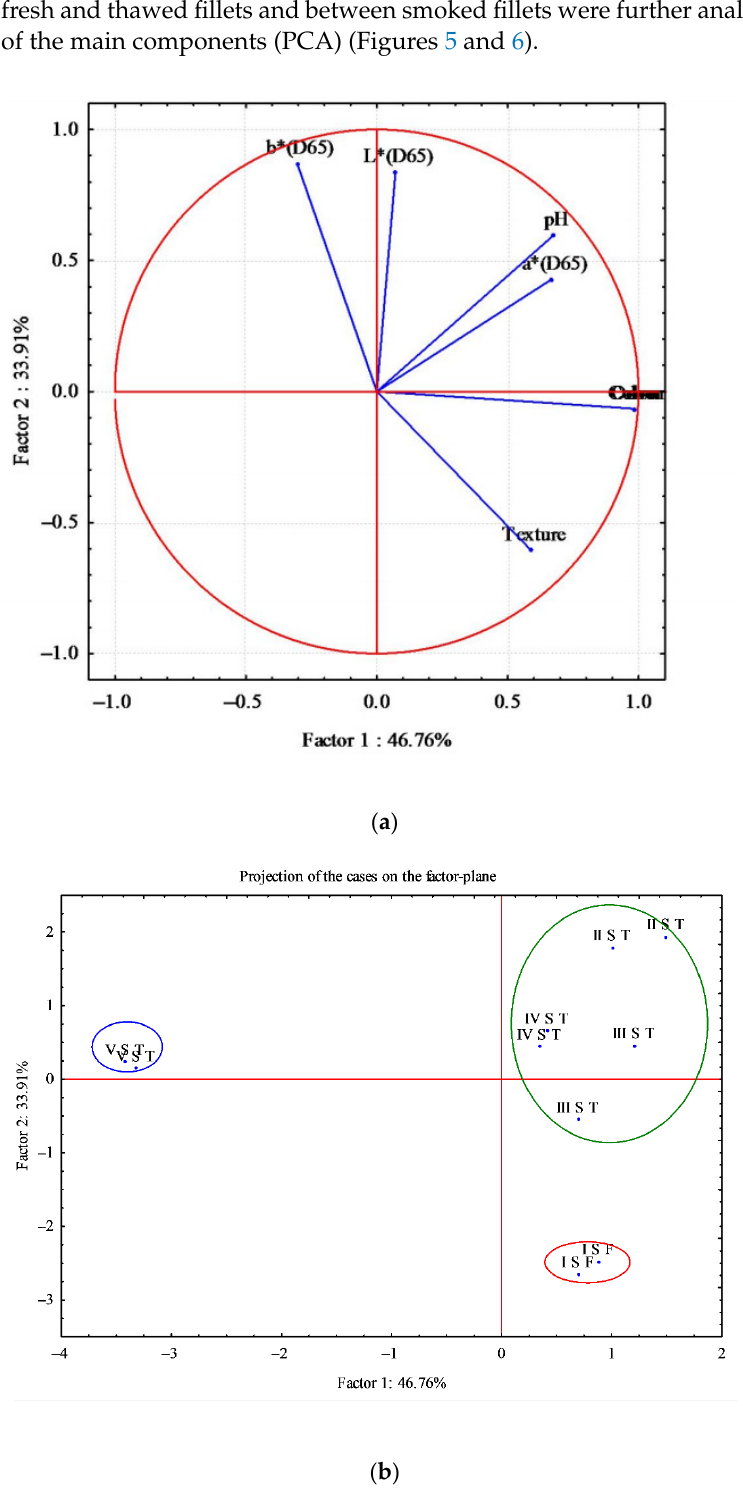
Figure 5. Principal component analysis (PCA) obtained from correlation of seven components (sensory analysis, pH, and color (L*, a*, b*) and 10 cases determined on fresh and thawed fillets of D. labrax . ( a ) Correlation circle; ( b ) Factor-plan.